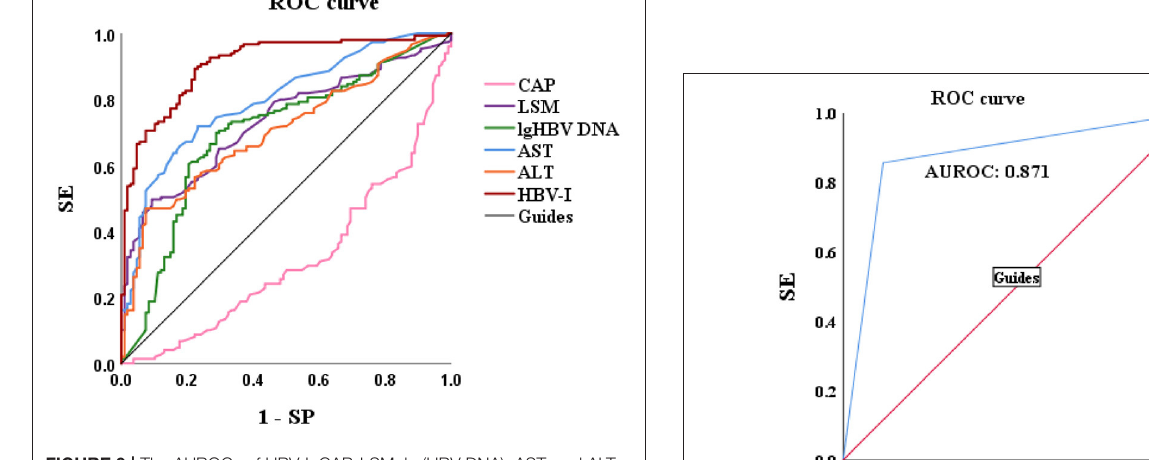
FIGURE 9 | The AUROCs of HBV-I, CAP, LSM, lg (HBV DNA), AST, and ALT for HBV-related inflammation of CBI patients with concurrent NAFLD. AUROC, area under the receiver operating characteristic curve; HBV-I, hepatitis B virus inflammation model; LSM, Liver stiffness measurement; HBV DNA was calculated by denary logarithm expressed as lg (HBV DNA); CAP, controlled attenuation parameter; LSM, Liver stiffness measurement; AST, aspartate aminotransferase; ALT, alanine aminotransferase; CBI, chronic HBV infection; NAFLD, nonalcoholic fatty liver disease; SE, sensitivity; SP, specificity; the AUROCs in HBV-I, CAP, LSM, lg (HBV DNA), AST, ALT were 0.907, 0.314, 0.732, 0.699, 0.797 and 0.704, respectively.